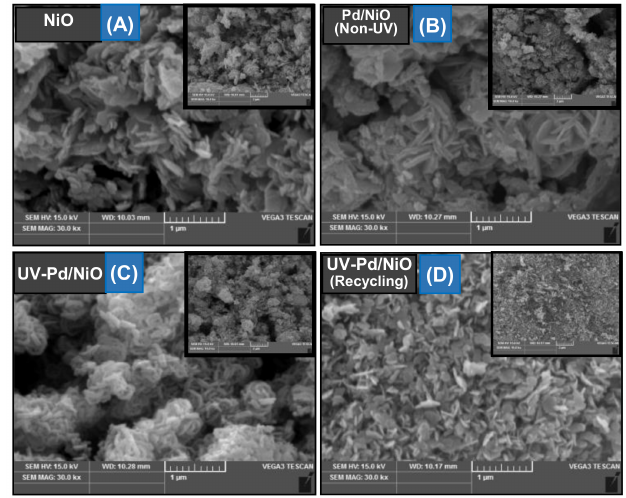
Figure 3. Scan electron microscope images of varied samples including NiO carrier ( A ) and Pd-based catalysts (UV-irradiation, B ; non-UV irradiation, C ; reused samples, D ) at an enlarged scale of 30,000 times. Meanwhile, corresponding SEM images of the same samples were inserted at a smaller scale of 10,000 times.